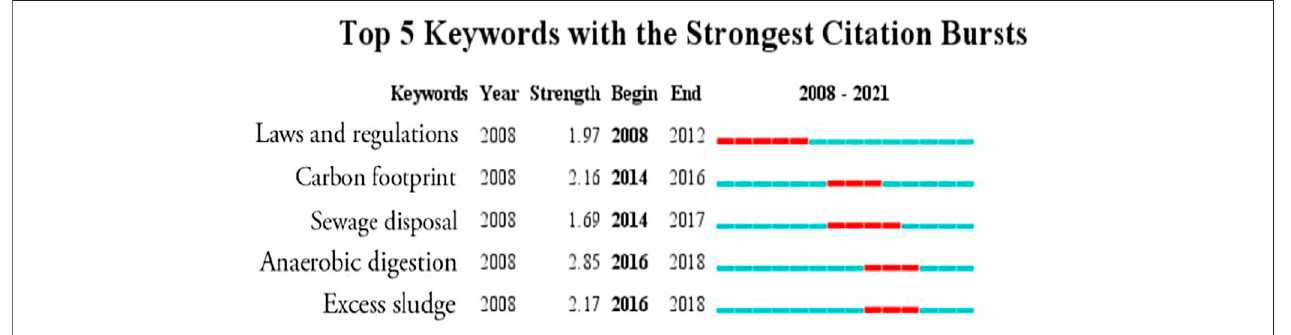
FIGURE 7 | Emergence of keywords in carbon neutralization research (2008 –